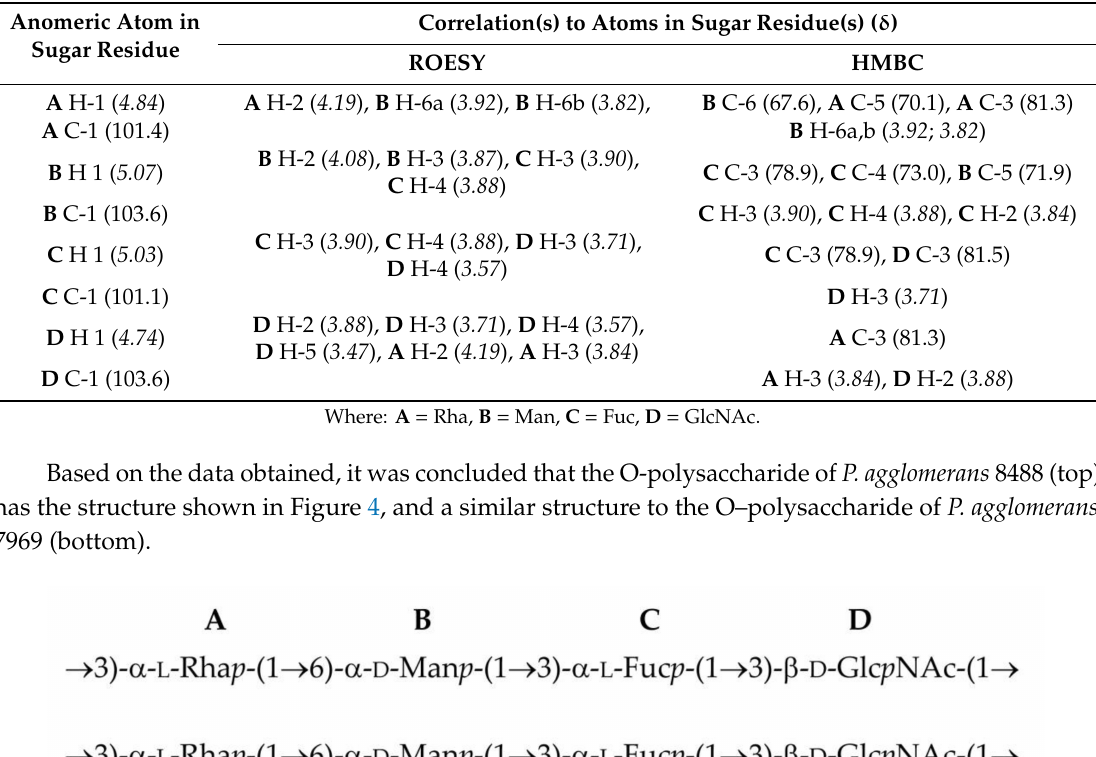
Table 3. Correlations for H-1 in the 2D ROESY spectrum of the O-polysaccharide of P. agglomerans 8488.